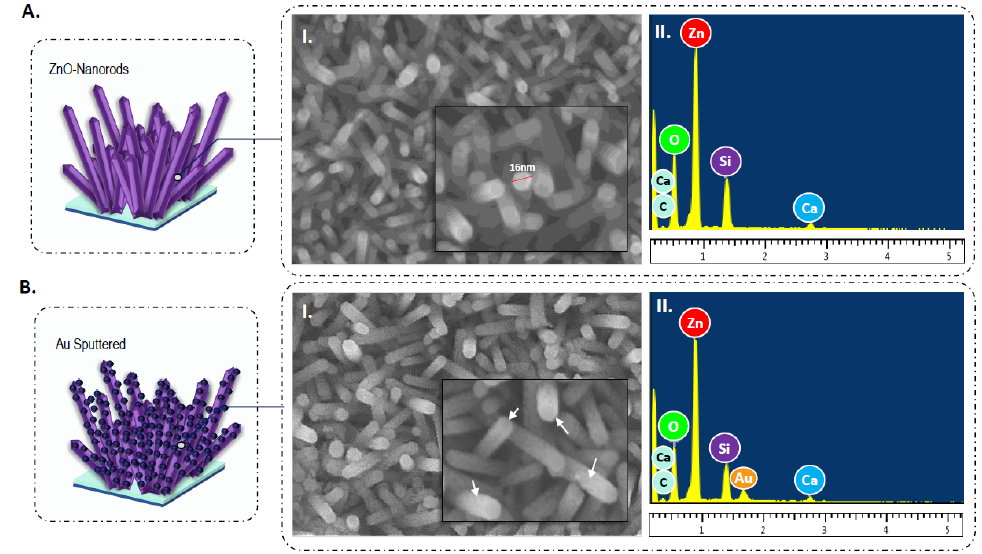
Figure 4. FESEM imaging of the surface grown ( A ( I )) ZnO-nanorods and ( B ( I )) ZnO-nanorods sputtered with gold with their analyzed EDX spectrum ( A ( II )) and ( B ( II )), respectively. The quality of the surface-coated matrix such as their crystallinity, grain size, and